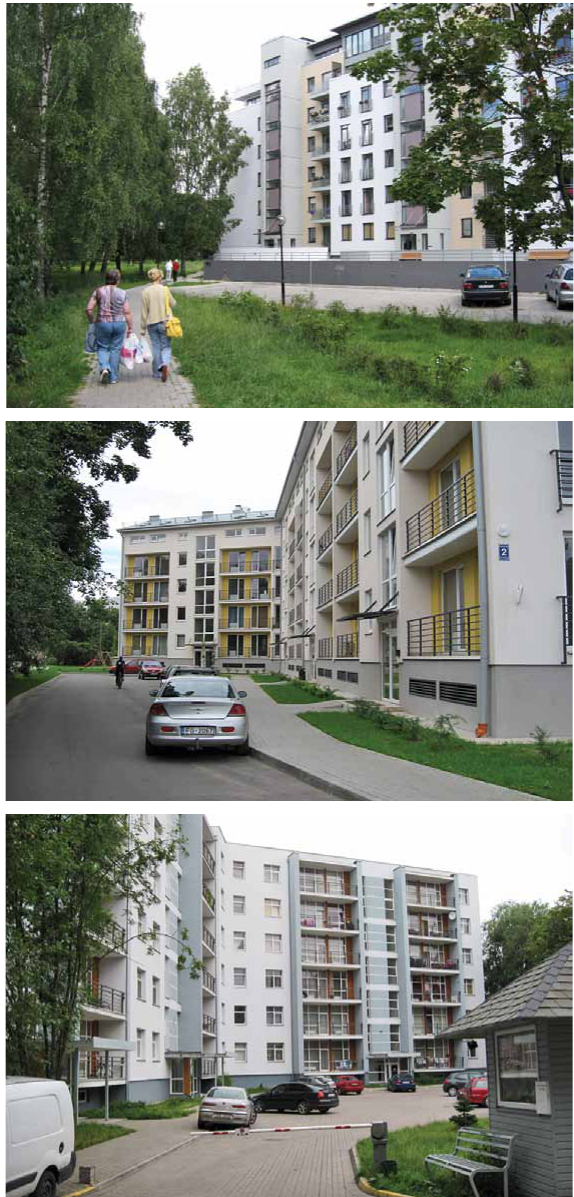
Figs. 5–7. new residential buildings built in former green open space in